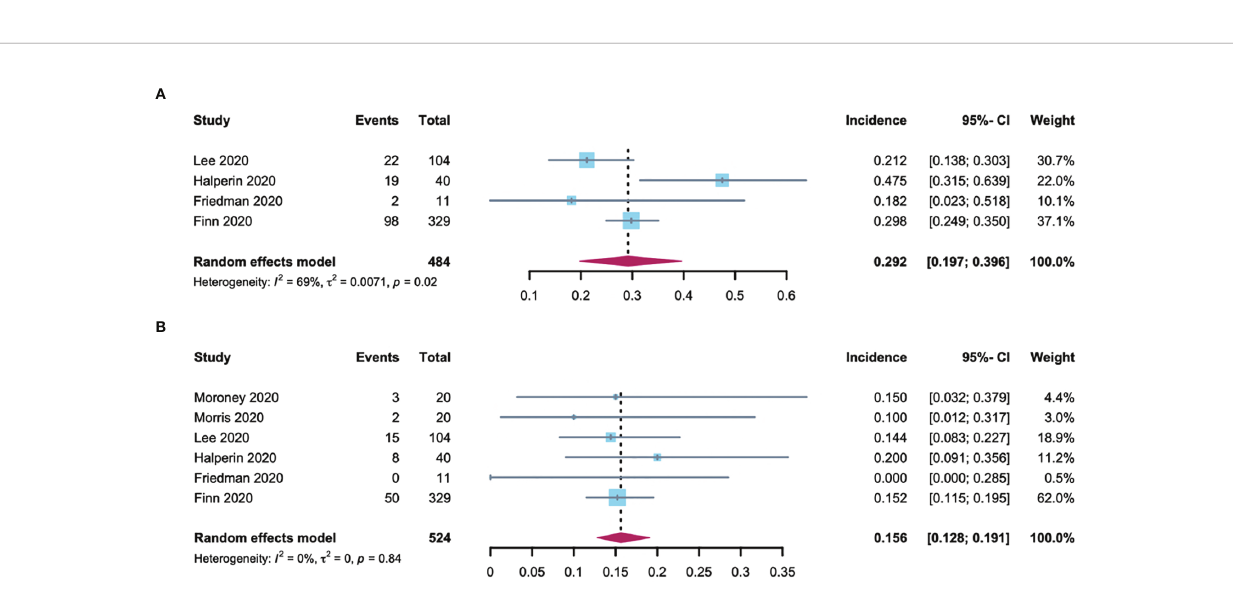
FIGURE 4 | Forest plot of the A-B-associated hypertension incidence in non-RCC patients. (A) incidences of all-grade hypertension with non-RCC; (B) incidences of high-grade hypertension with non-RCC.